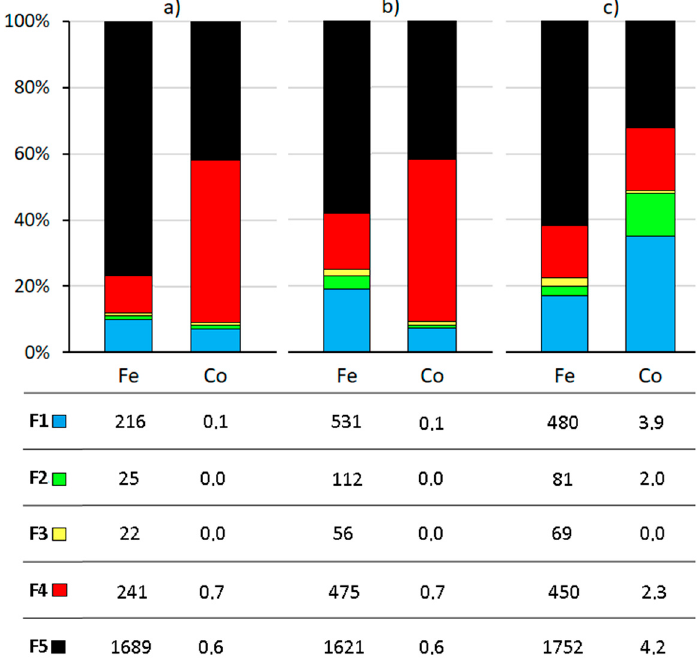
Figure 3. Water soluble (F1), exchangeable (F2), carbonate-bound (F3), sulfide bound (F4), and residual (F5) fractions of Fe and Co in the biochemical methane potential (BMP) tests on day 5. Columns ( a ) show the speciation of Fe and Co in the rice straw without trace element (TE) addition. Fe and Co fractions in the rice straw with only Fe addition are displayed in columns ( b ). Fe and Co fractions in the rice straw when both TEs were externally dosed are shown in columns ( c ). All values are expressed as µg TE/g TS.